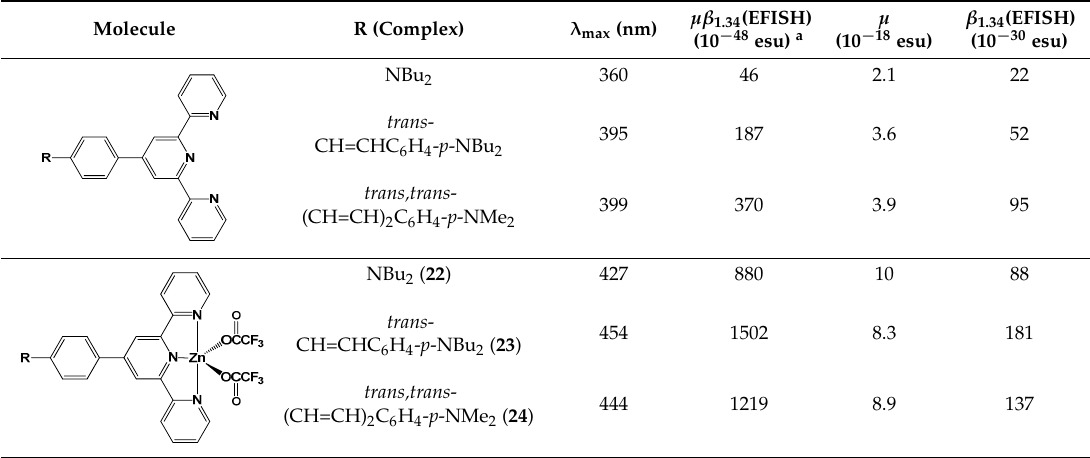
Table 4 . Electronic spectra, dipole moments, and β 1.34 (EFISH) of Zn(II) terpyridine complexes in CHCl 3 solution [49,50].